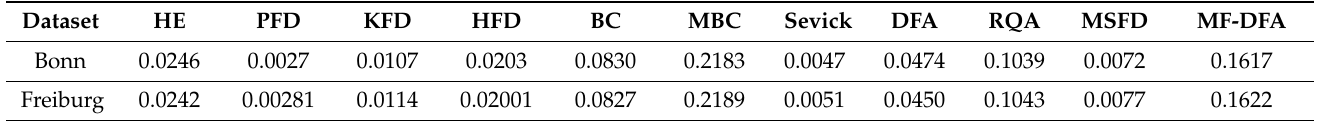
Table 6. The execution time of each FD method.